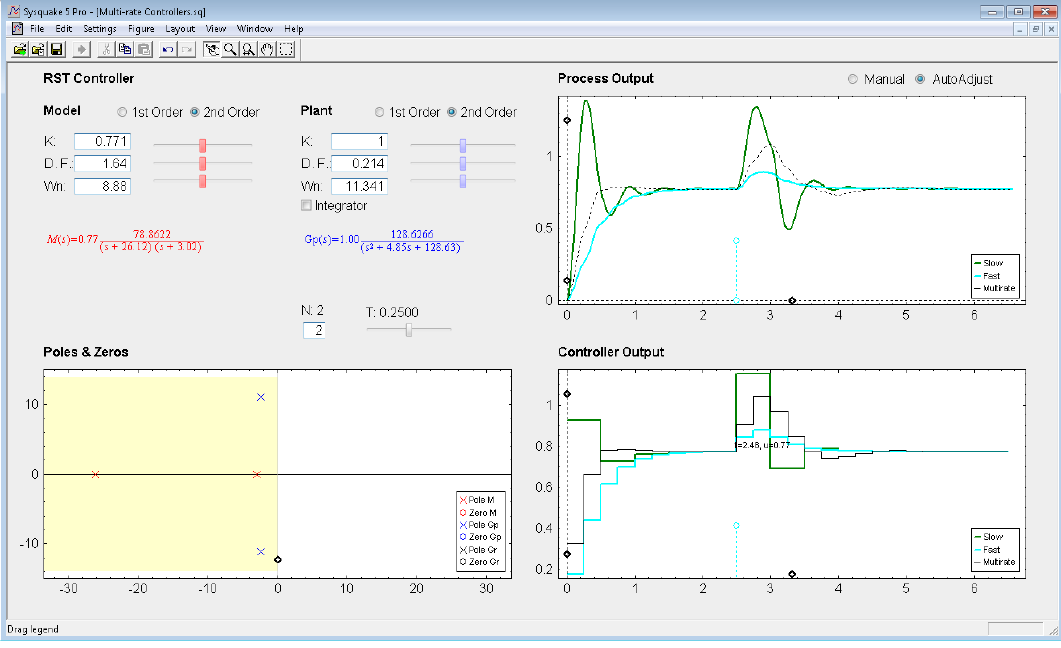
Figure 15. Application user interface for the RST